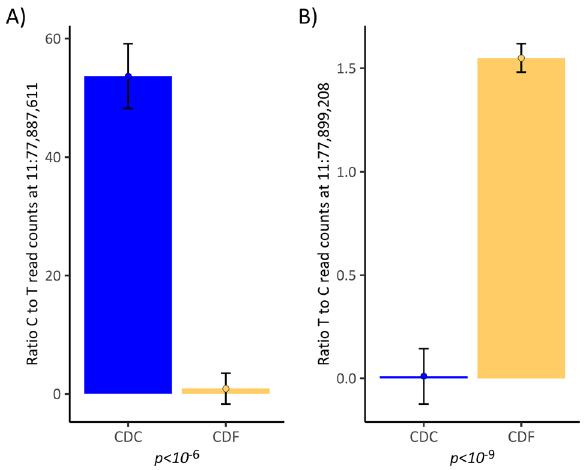
Figure 5. Ratio of reads mapping to alternative haplotypes for SNP positions in exon 3 (position 11:77,887,611) and exon 13 (position 11:77,998,208) of the APOB gene in CDC and CDF cows. ( A ) Ratio of C (allele on LTR insertion carrying haplotypes) to T (allele on the wild type haplotype in CDC animals), ( B ) ratio of T (allele on LTR insertion carrying haplotypes) to C (allele on the wild type haplotype in CDC animals). Indicated are lsmeans ± standard